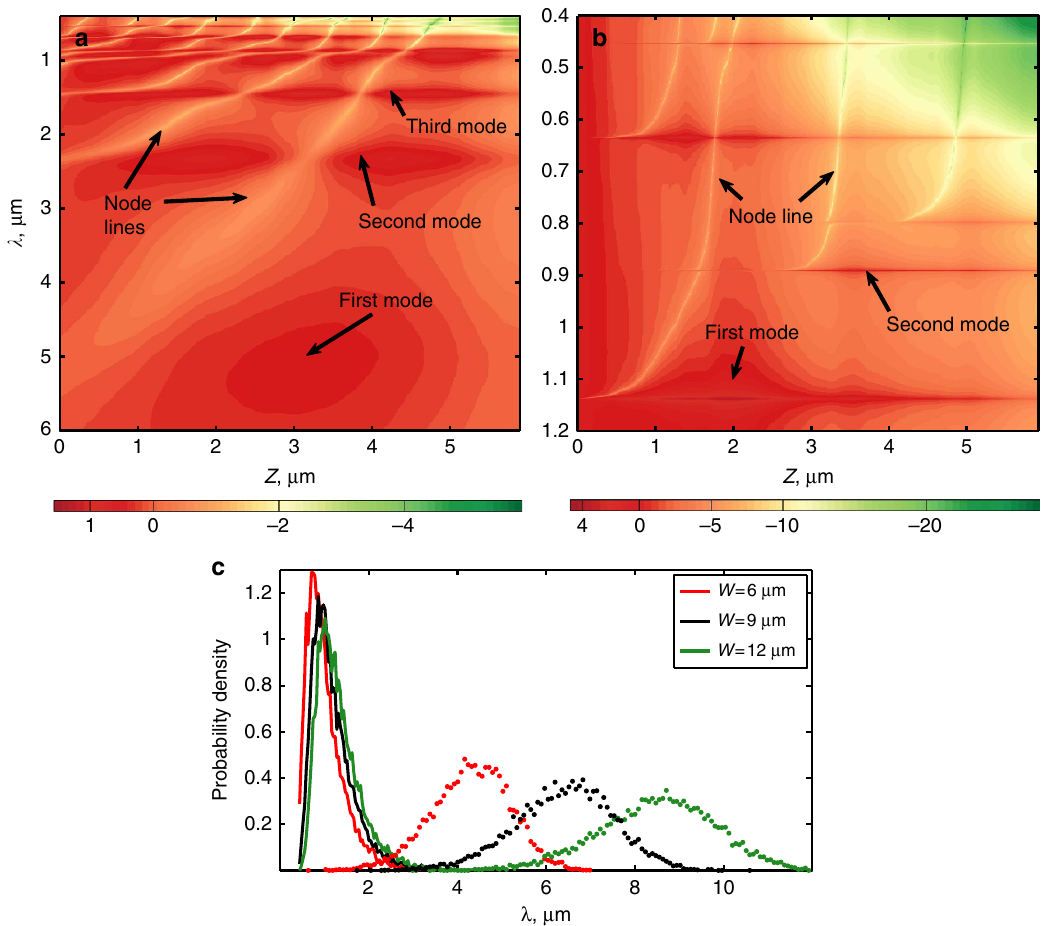
Figure 5 | Mapping of the first transmission modes above and below h c . ( a ) Distribution of log 10 of the intensity, as a function of z (the location inside the sample) and wavelength l . The colourmap is normalized. This plot represents a specific (arbitrarily chosen) structure with N ¼ 300 layer pairs illuminated at y ¼ 58 (cid:2) . Note that the colourbar immediately below is logarithmic (powers of 10). ( b ) Same as ( a ), for illumination at y ¼ 62 (cid:2) . ( c ) Probability distribution of the wavelength of the first mode for two angles of incidence y ¼ 58 (cid:2) (dotted line) and y ¼ 62 (cid:2) (solid